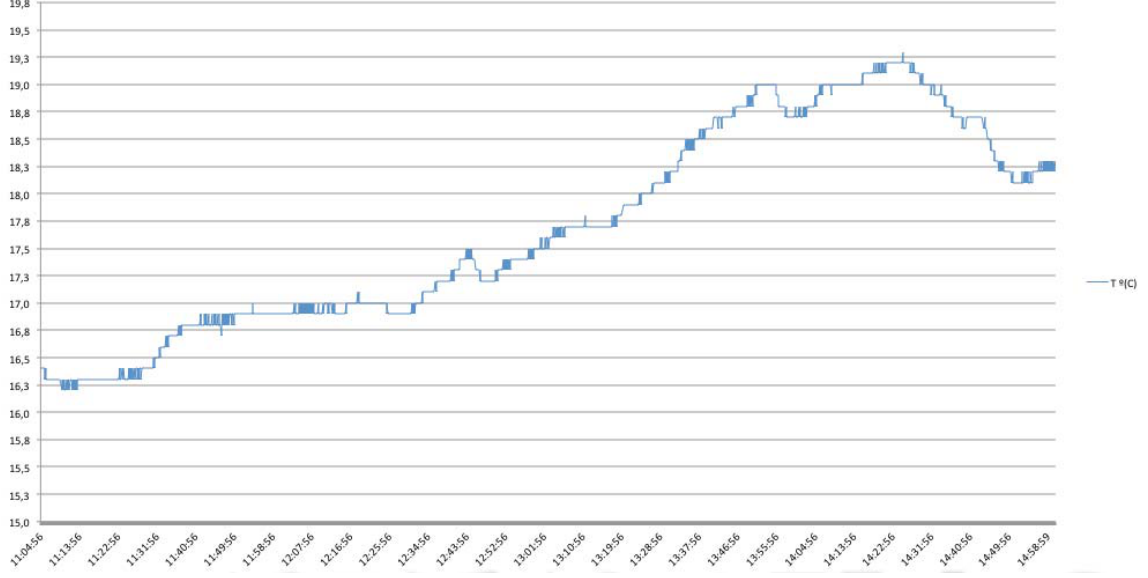
Figure 29. Temperature measurements during 4 hours.